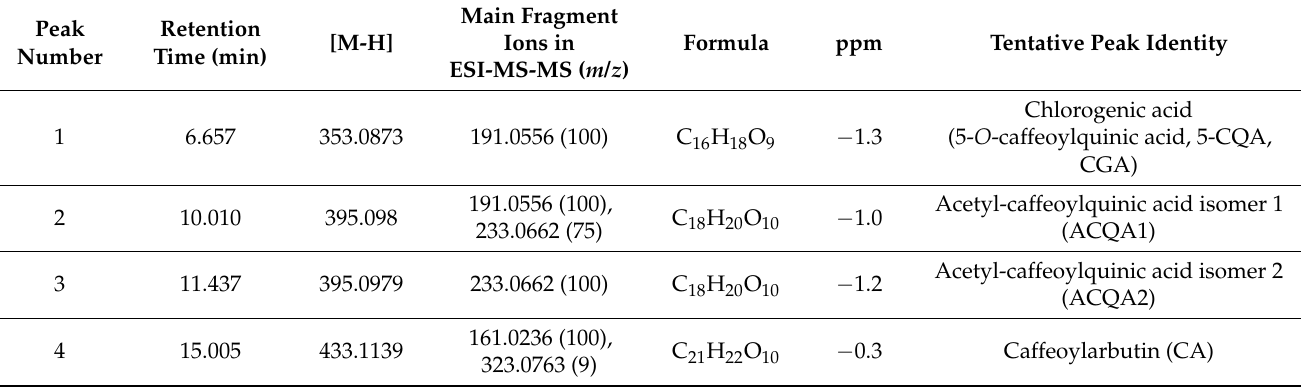
Table 1. Phenolic acids identified in blueberries. ESI-MS-MS: electrospray ionization-tandem mass